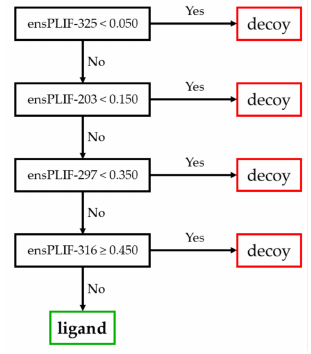
Figure 1. The best decision tree to identify ligand for